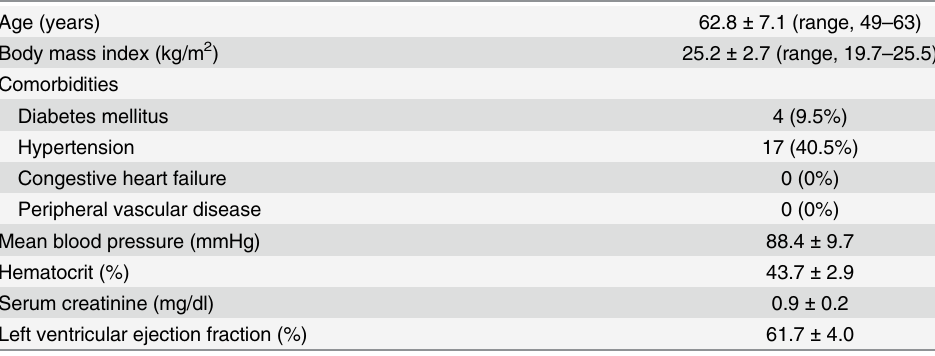
Table 1. Demographics and preoperative